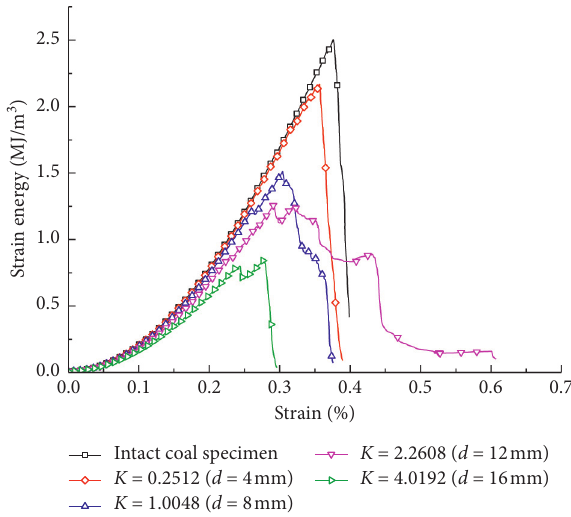
Figure 4: Curve of strain energy U